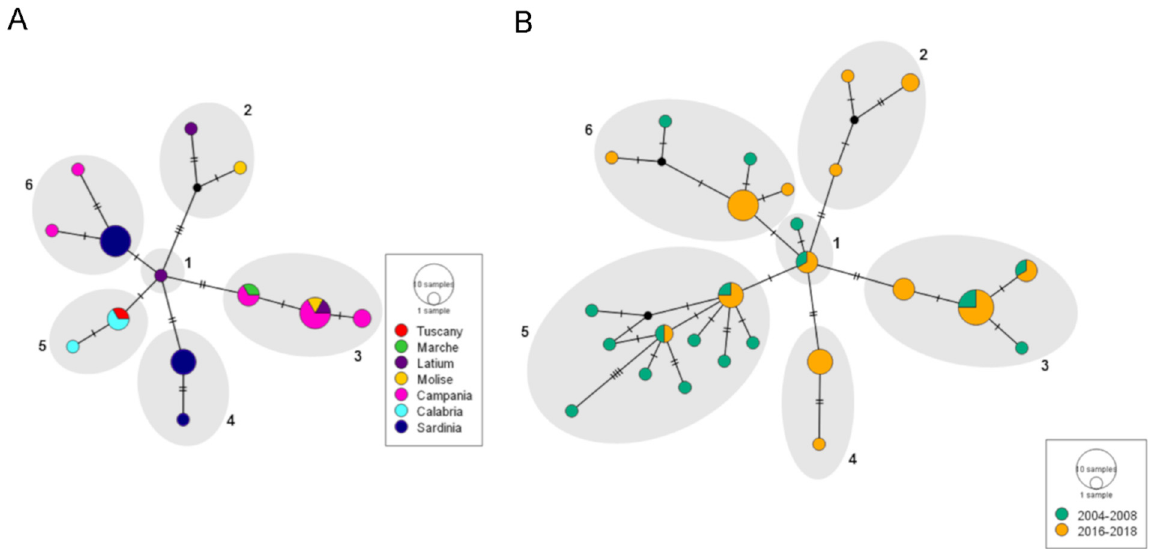
Figure 4. Median Joining haplotype networks showing ( A ) the geographic relationship among thirteen MEDQ1 haplotypes of Bemisia tabaci collected in Italy between 2017 and 2018; ( B ) the temporal relationship among the MEDQ1 haplotypes of B. tabaci at two collection periods, 2004–2008 and 2016–2018. The main haplotype groups (1–6) are hand-drawn to assist in